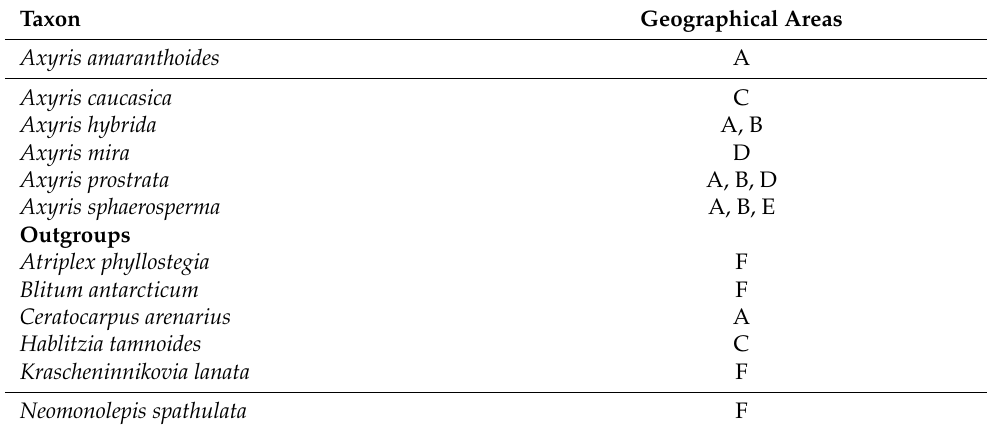
Table 3. The coding of the geographic areas of Axyris species and